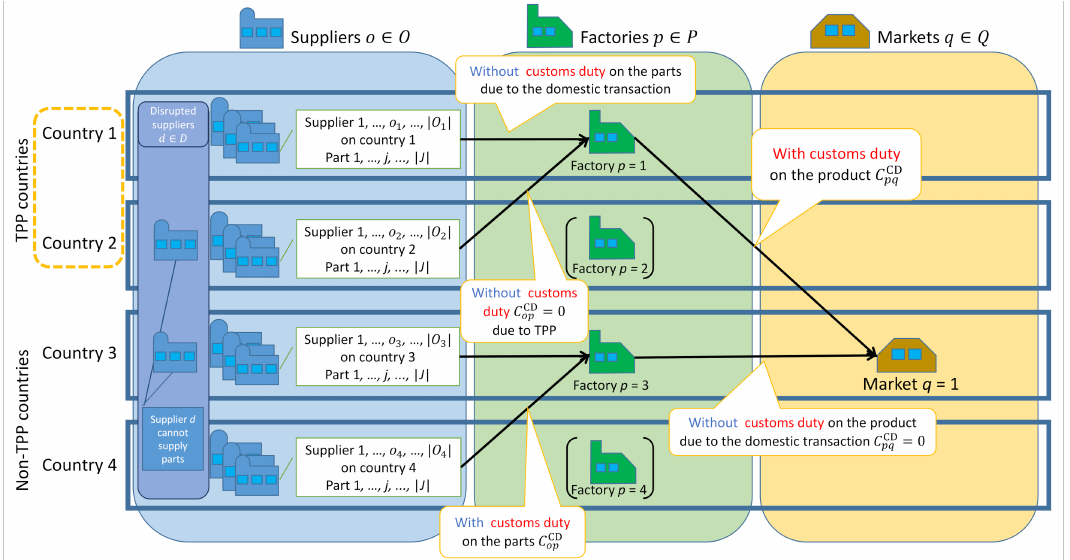
Figure 2. Global supply chain network model considering disruption and TPP: Case of 4 countries. This proposed model is applied at the strategic planning stage of a global supply chain, following Urata et al. [33], where a just-in-time environment is assumed in this study, which represents fewer inventory operations. Thus, inventory control, including lead time, is outside the scope of this